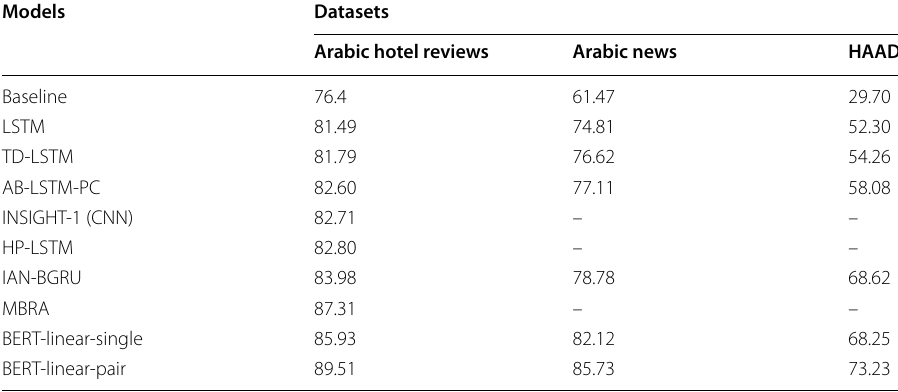
Table 3 Models accuracy results on the Arabic hotel reviews dataset, Arabic news dataset, and